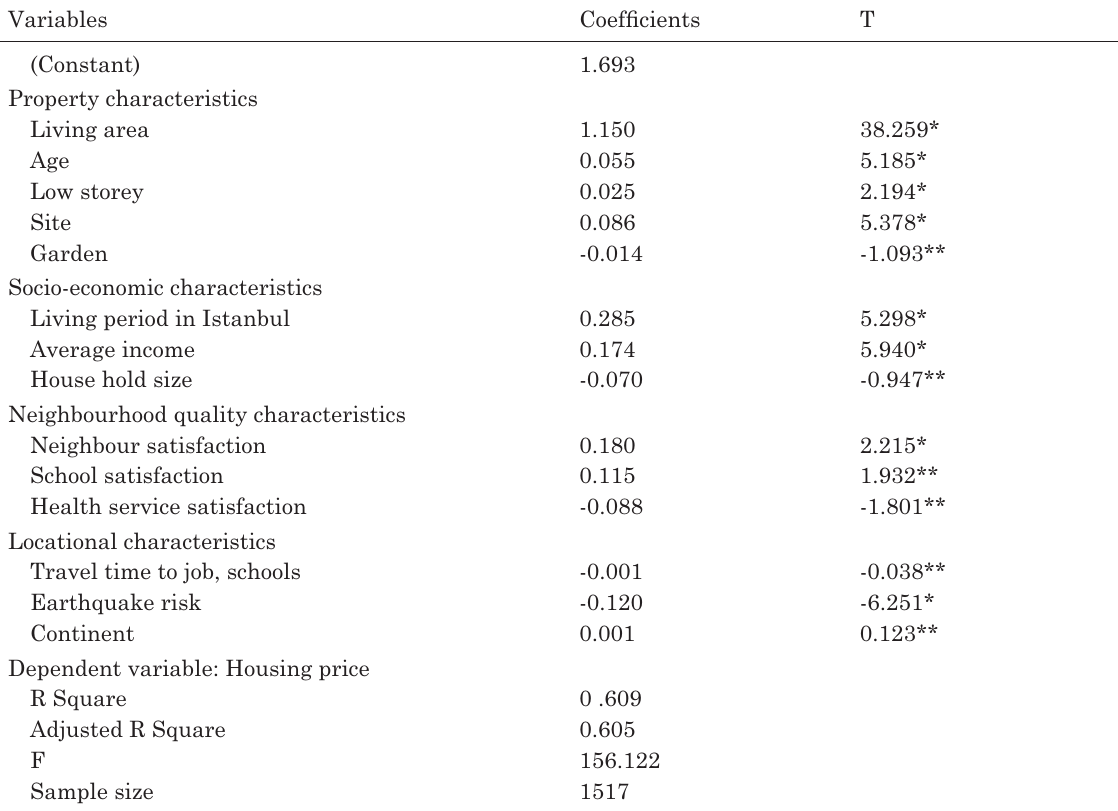
Table 4. The results of the